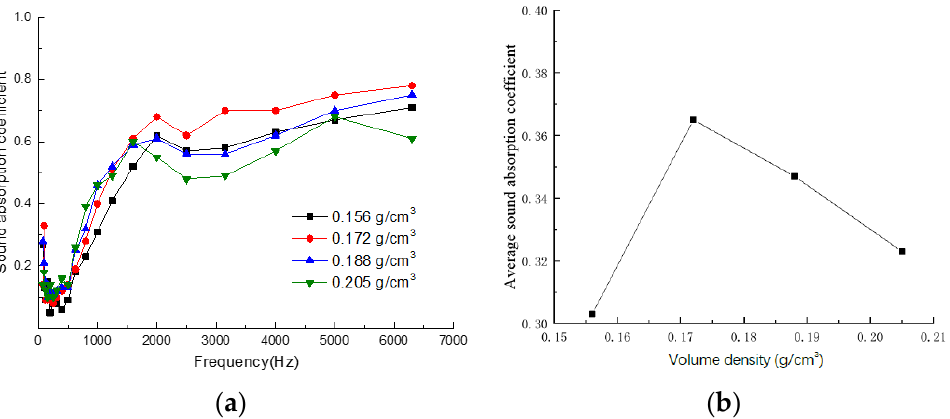
Figure 2. Influence of volume density on sound-absorption coefficient: ( a ) sound-absorption coeffi- cient, ( b ) average sound-absorption coefficient .